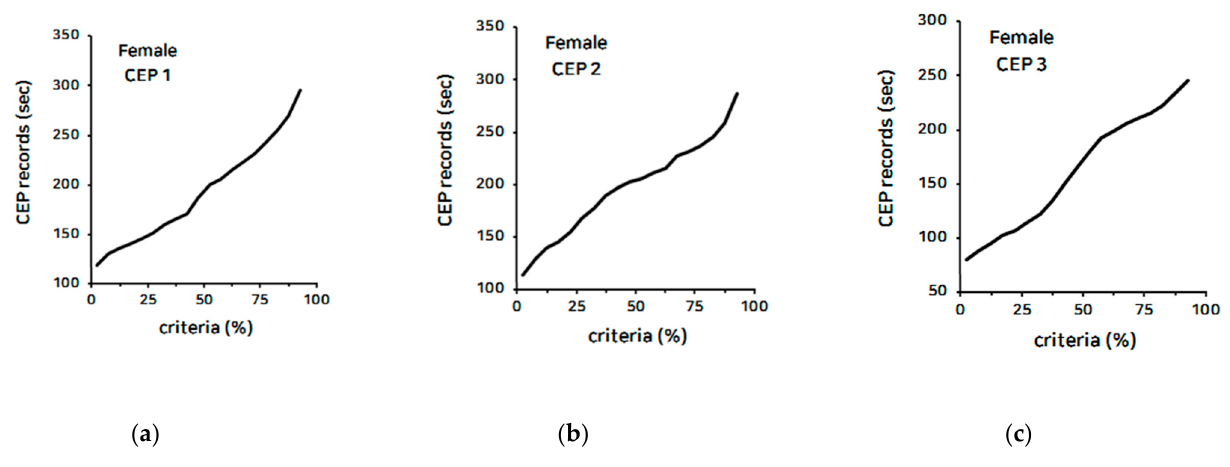
Figure 2. The criteria of circuit exercise program for females: ( a ) circuit exercise program 1; ( b ) circuit exercise program 2; ( c ) circuit exercise program 3.